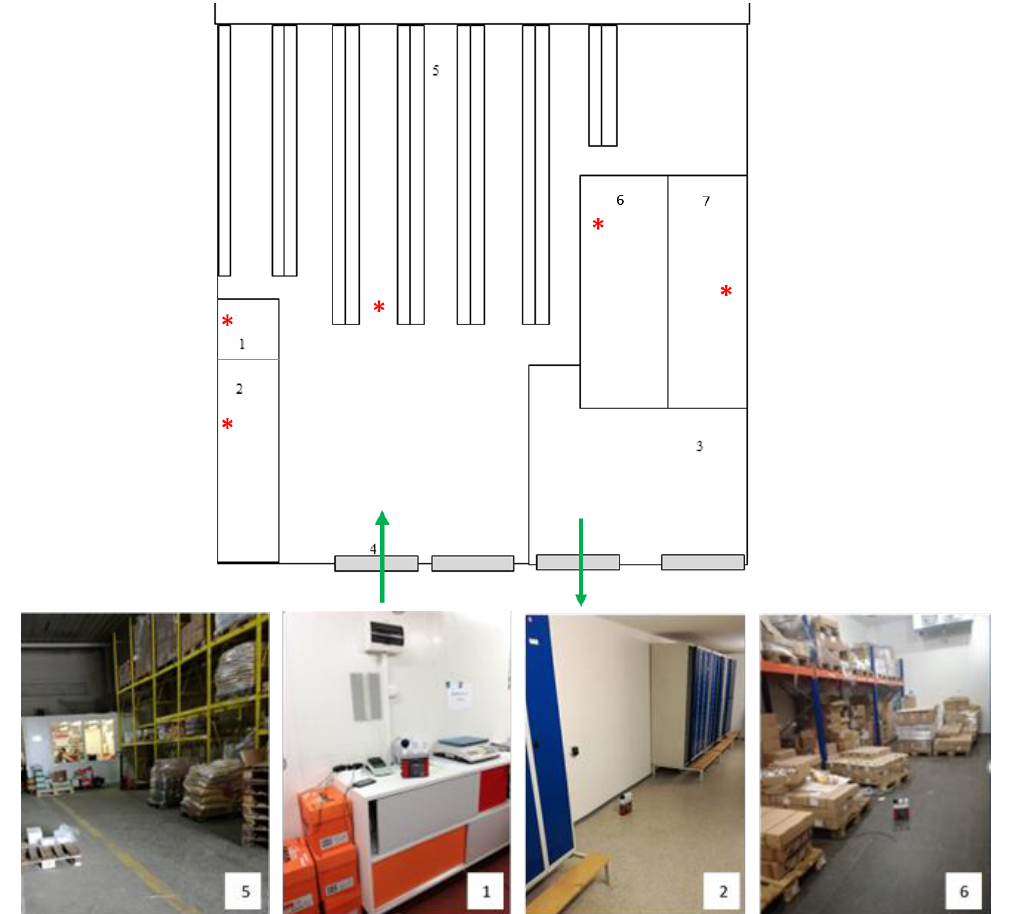
Figure 1. Ground plan of the warehouse with experimental points. Legend: 1 — Office in the warehouse; 2 — Changing rooms and toilets inside the warehouse; 3 — Expedition place; 4 — Loading ramp; 5 — Storage room; 6 — Cold room refrigerator in the warehouse, 7 — Freezer room; * — experimental point.